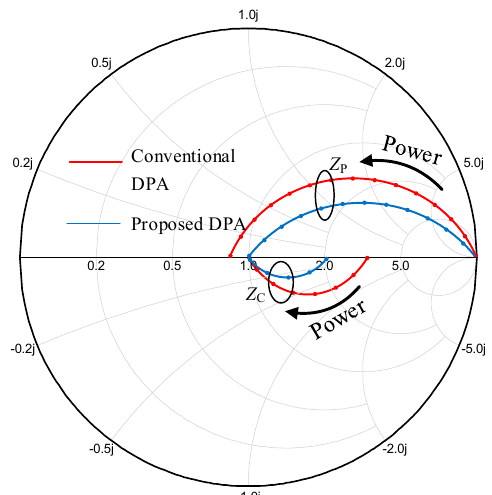
Figure 13. Simulated internal drain load impedance trajectories of the carrier and peak PA (normalized to R OPT ).